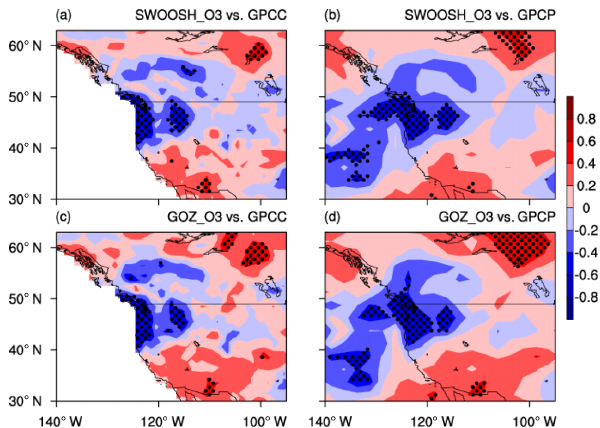
Figure 1. Correlation coefficients between March ASO and April precipitation variations calculated from SWOOSH (a, b) and GOZ- CARDS (c, d) ozone, and GPCC (a, c) and GPCP (b, d) rainfall for the period 1984–2016. Dots denote significance at the 95% confi- dence level, according to Student’s t test. The long-term linear trend and seasonal cycle in all variables were removed before the corre- lation